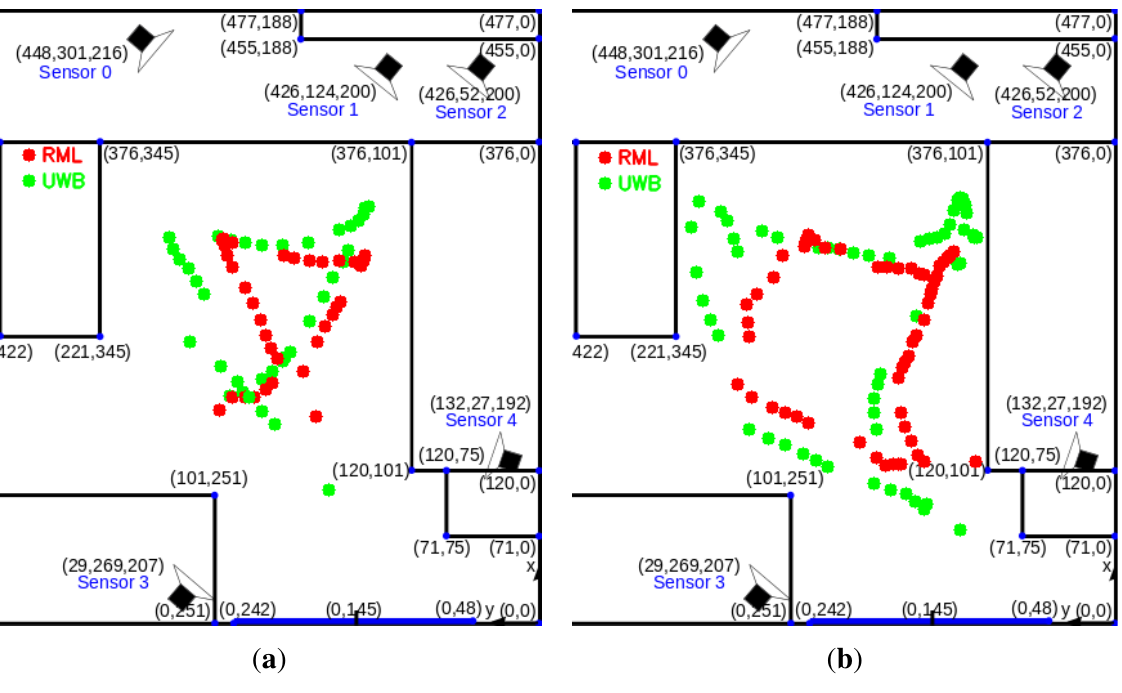
Figure 10. Comparison between RML tracks (blue) and UWB tracks (green). ( a ) Track 1; ( b ) Track